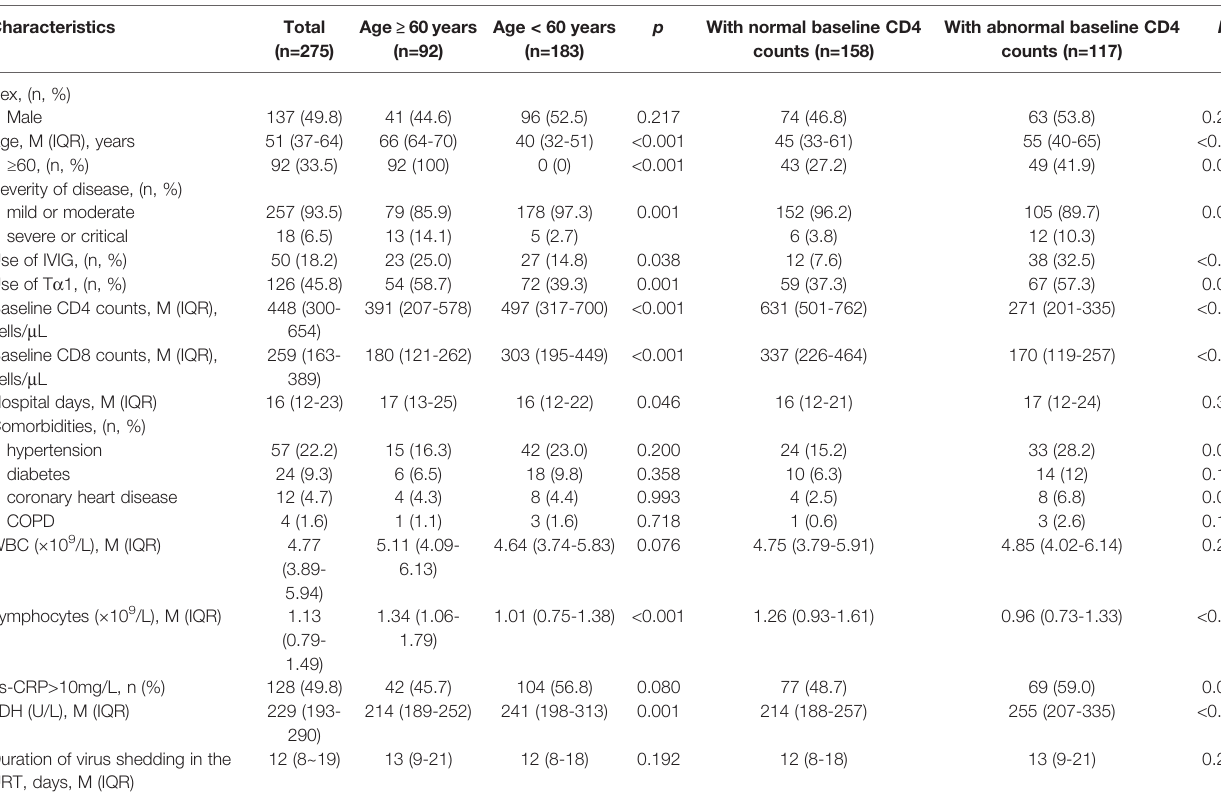
TABLE 1 | Demographic and clinical characteristics of patients with COVID-19.